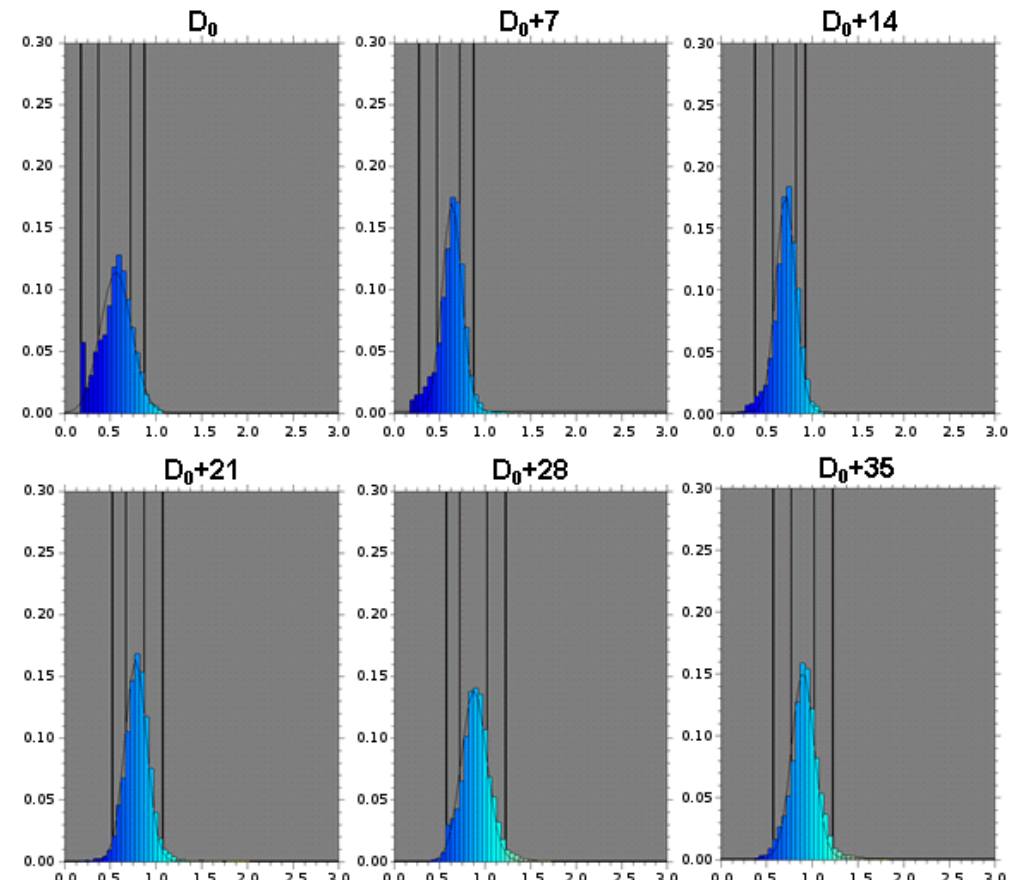
Figure 16. Evolution of the PDF of the ratio for the Envisat satellite from D 0 to D 0 + 35 days. D 0 corresponds to the first day when Envisat is assimilated by the